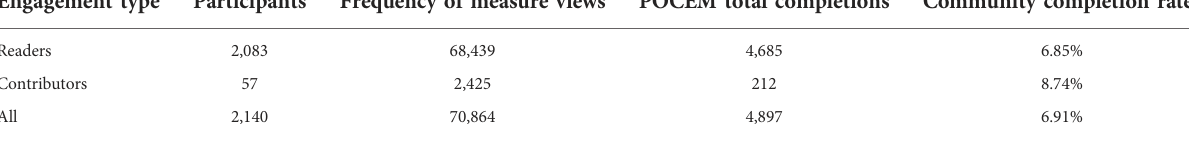
TABLE 6 The unique users, POCEM completions, and proportion of completions within the